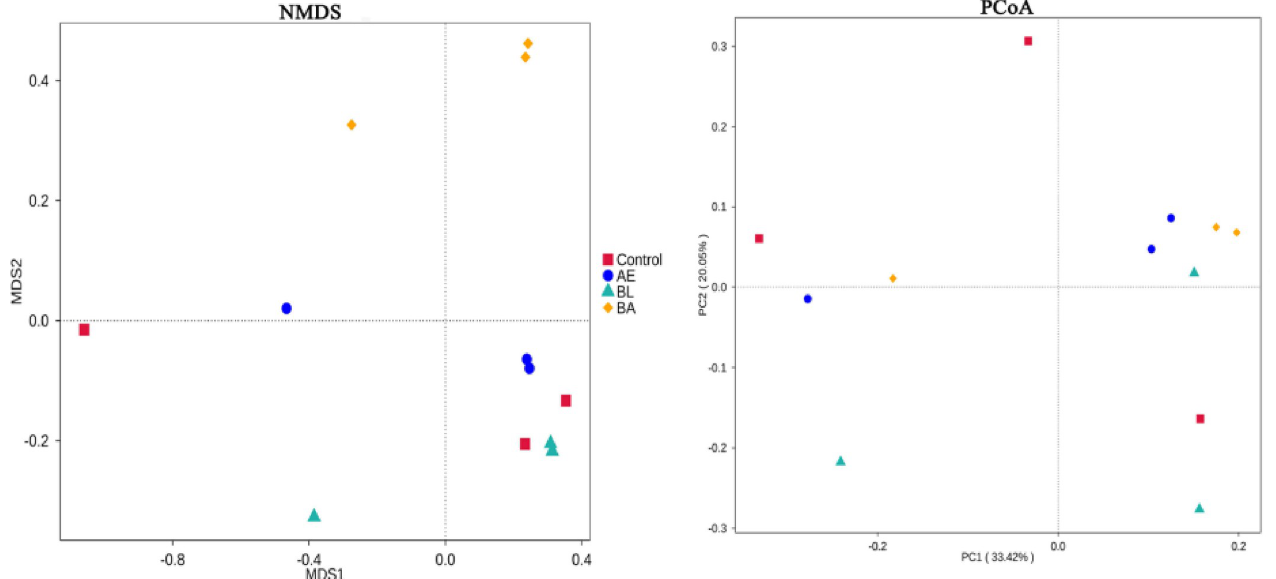
Fig 6. NMDS analysis and PCoA showing the shifts in the bacterial communities driven by BL, AE and BA among all samples. AE: Astragalus membranaceus extract, BL: Bacillus licheniformis and BA: Bacillus micheniformis and Astragalus membranaceus extract.